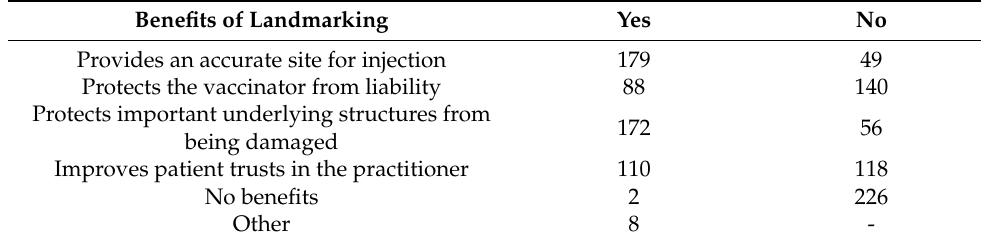
Table 6. Respondent nominations of benefits of landmarking